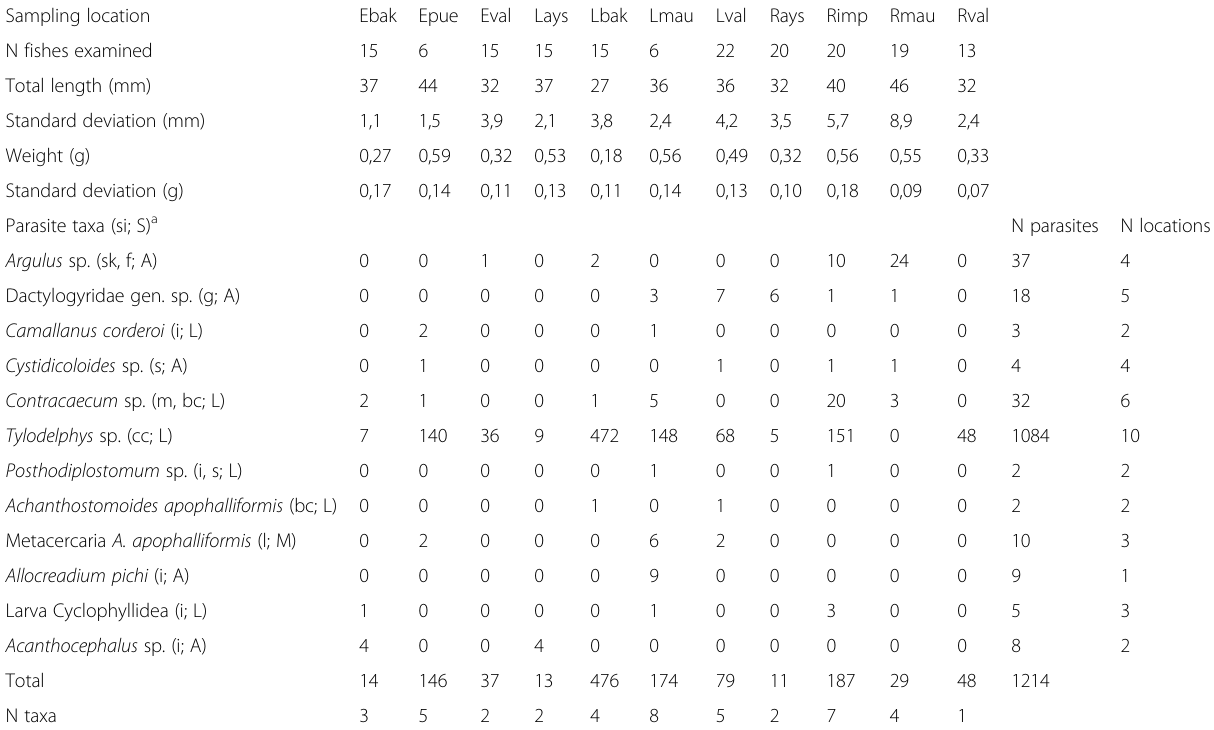
Table 1 Number of fish examined, total length (mm), weight (g) standard deviation, and number of parasites per sampling location and taxon. Total number of taxa per location (last row) and total number of parasites per location as well as the range of locations in which each taxon occur (right